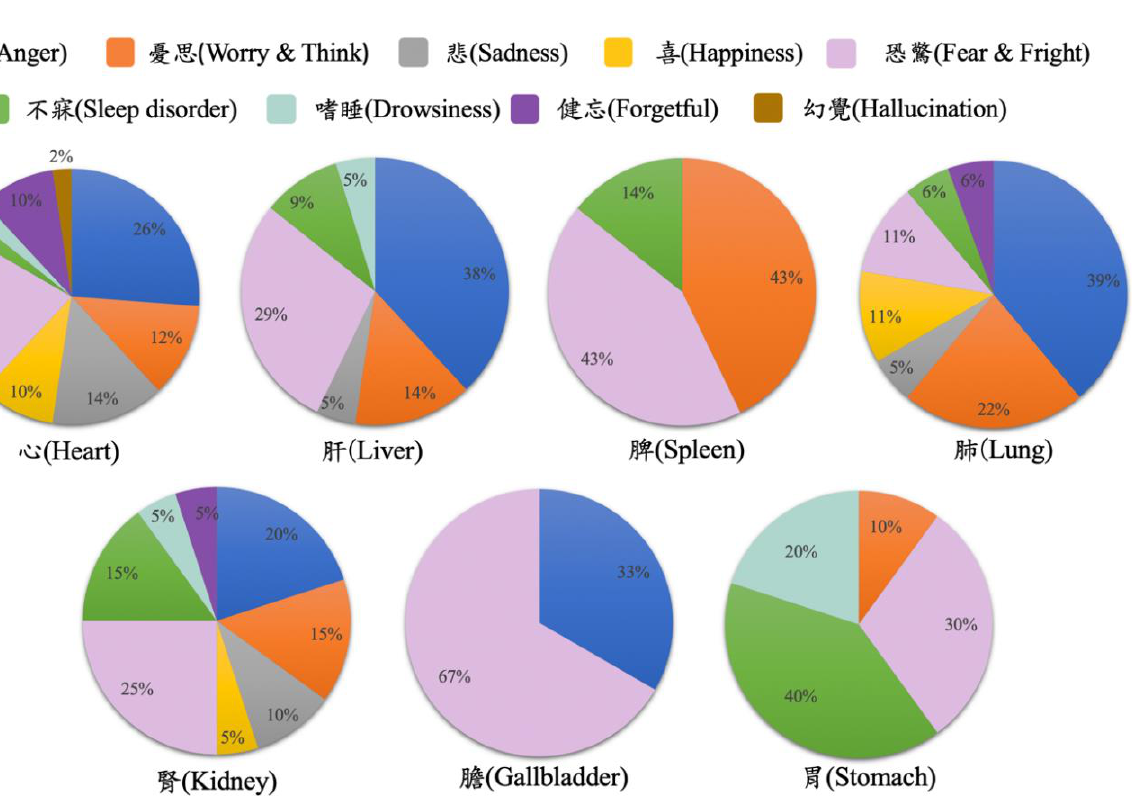
24 % Figure 3. The ratio of top 10 descriptions of the five depots and two palaces. In biomedicine, the heart is an organ that pumps blood throughout the body, provid- ing oxygen and nutrients for bodily functions. Meanwhile, in TCM, the heart is responsi- ble for the regulation of mental activities [10 – 12]. TCM views the heart as being in control of blood circulation, regulating blood vessels, and storing the spirit (“shen”, “ 神 ”), which implies consciousness and other cognitive functions [10 – 13]. Internal organs rely on the heart and blood for sufficient nourishment. The heart is comprised of heart qi, heart yang, heart blood, and heart yin. A dysfunction in the heart may result in poor circulation and, thus, generates symptoms such as coldness of limbs, and a white or purple complexion [10]. Moreover, previous studies [14,15] have evidenced that heart problems may double the risk of cognitive impairment without memory impairment [16,17]. Previous studies have also suggested the possibility of comorbidity between cardiovascular diseases and mental disorders. In [18,19], the authors demonstrated that chronic mental disorders